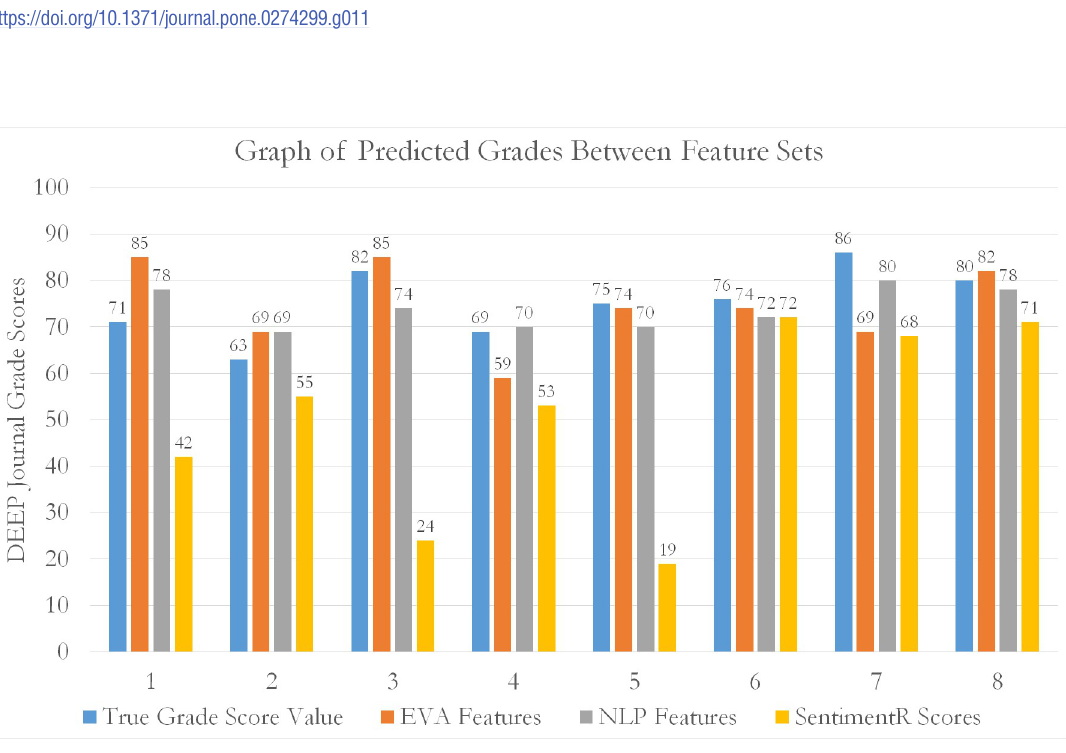
PLOS ONE | https://doi.org/10.1371/journal.pone.0274299 January 12,